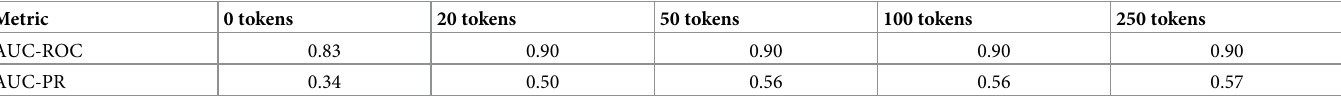
Table 2. The area under the curve (AUC) for ROC and PR of random forest models. All models include 15 refined clusters. The additional number of tokens is shown as the column names.